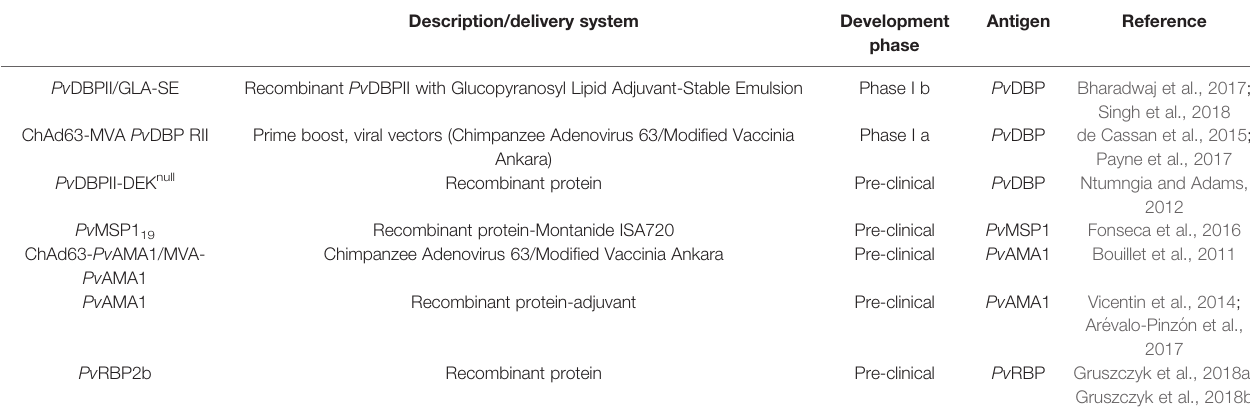
TABLE 1 | Plasmodium vivax blood stage vaccine